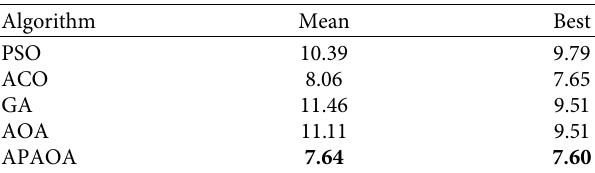
Table 10: Comparison of the APAOA with the GA, PSO, ACO, and AOA in environment 2.